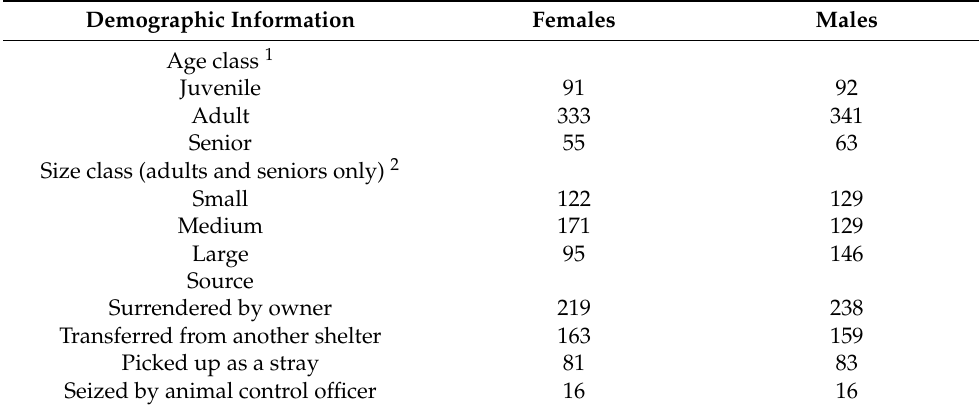
Table 1. Demographic data for the 975 dogs included in the